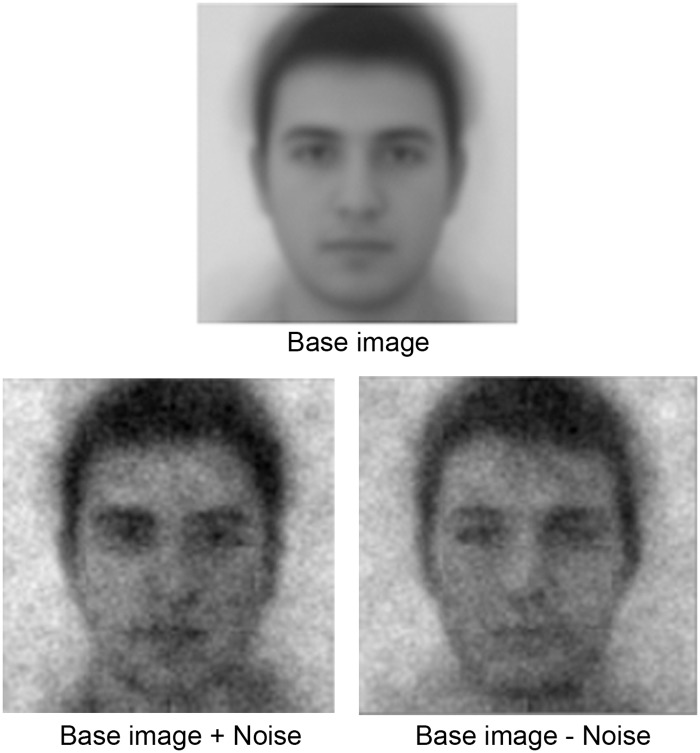
Stimuli Used in the Reverse Correlation Paradigm.Base image and an example of pairs of faces presented on a trial of the classification task.